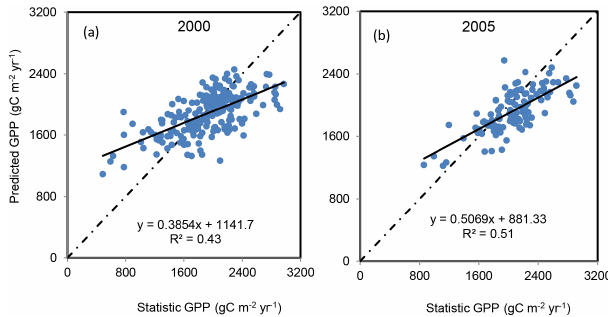
Figure 4. Comparisons of the predicted GPP and statistic yield de- rived GPP at county scale in 2000 and